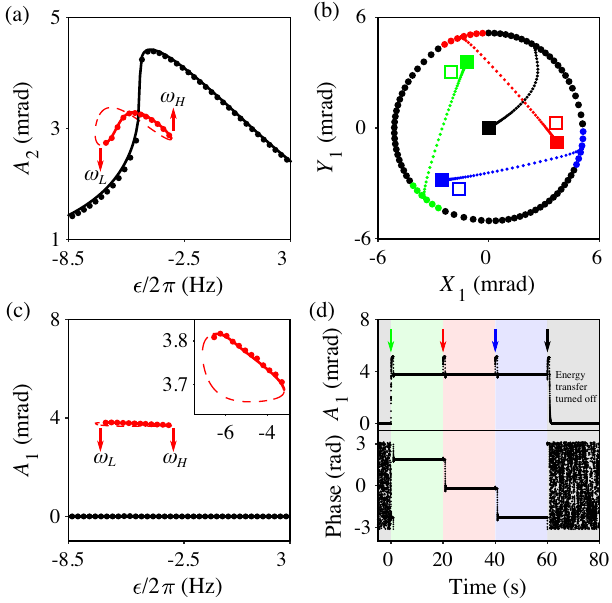
FIG. 2. (a) Amplitude A 2 of mode 2 as a function of the frequency detune ϵ ¼ ω d − ω 2 of the drive on mode 2 at a pump voltage of 6 mV and a mode frequency mismatch of ϵ = 2 π ¼ − 16 . 4 Hz. The solid and dashed lines are stable and 1 unstable vibration states, respectively, calculated using Eq. (3). Circles are measured results. For the black data, mode 1 is in the zero-amplitude state. For the red data, mode 1 is in the red period- tripled state. The behavior of mode 2 is measured to be identical, within detection noise, regardless of whether mode 1 is in the red, green, or blue period-tripled state. (b) Under the perturbation of a secondary drive applied to mode 1, vibrations of mode 1 are excited, the phase of which depends on the phase of the secondary drive. The initial state lies approximately on a circle in the phase space of mode 1. The color of the large circles indicates to which final state (squares) mode 1 settles after removal of the secondary drive. For each of the four final states, a trajectory is shown (small circles) for one chosen initial state. The hollow squares denote the three saddle points calculated with Eq. (3). (c) Amplitude A 1 of mode 1 versus the frequency detune ϵ with the same color scheme as (a). If ϵ is swept beyond ω ω H , the response jumps to the black curve. Inset: enlargement of the isolated loop. (d) Pulses of the secondary drive are applied at time t ¼ 0 , 20, and 40 s (arrows) to change the vibration phase of mode 1. Energy transfer from mode 2 is turned off at t ¼ 60